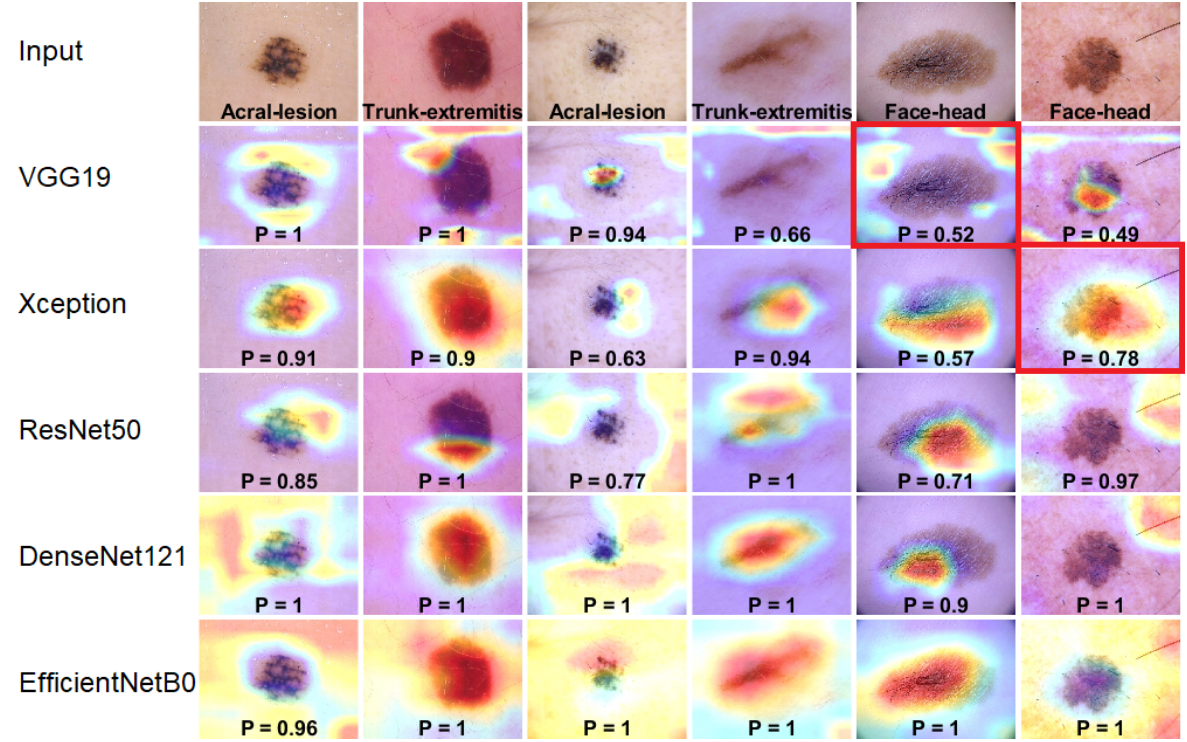
Figure 8. Grad-CAM visualization results. We compare the visualization results for each integrated pre-trained network based on the classification of skin lesion into the anatomic site of the body. The input image is shown on the top, and P denotes the Softmax